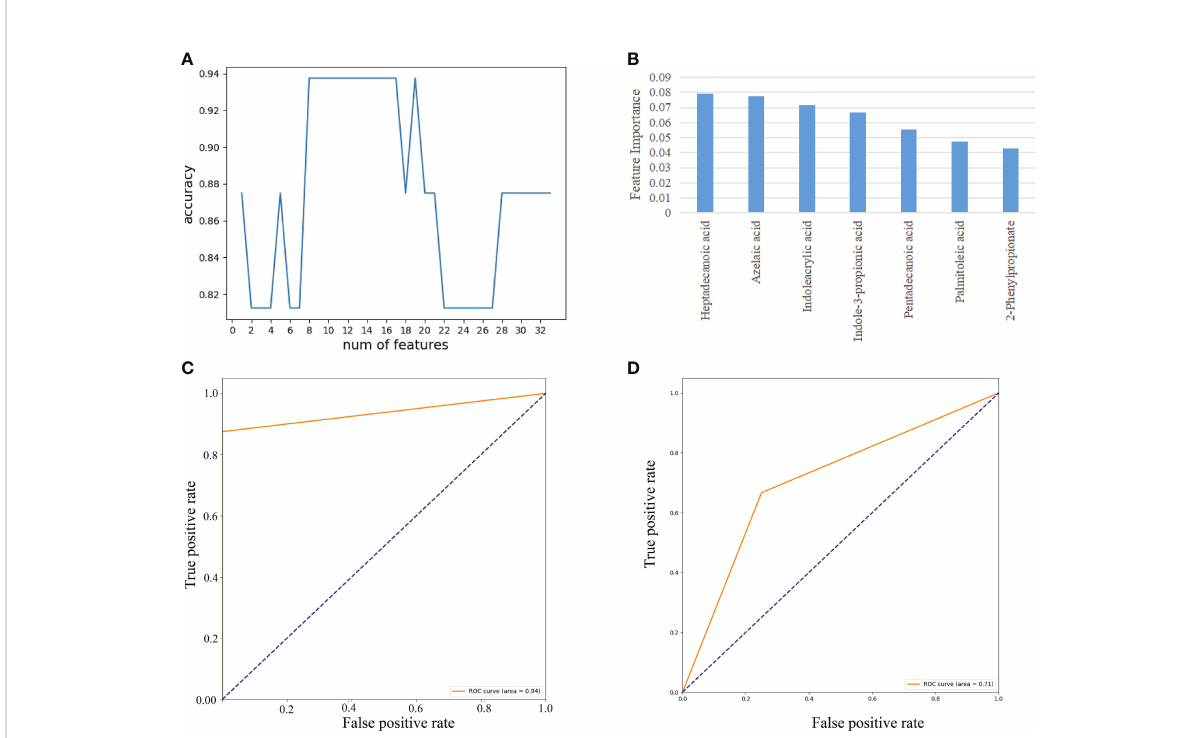
FIGURE 7 Feature selection of fecal metabolites by using the random forest (RF) and evaluation using the ROC curves. (A) The accuracy changes of classi fi cation model on the A sample set. (B) The importance in descending order (7 fecal metabolites). (C) Evaluation using ROC curve on the A sample set. (D) Evaluation using ROC curve on the C sample